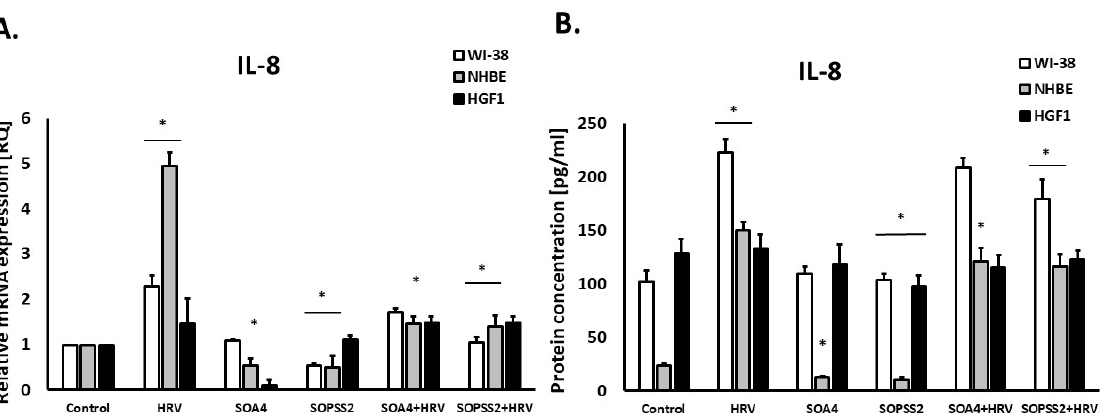
Figure 2. The effect of the extracts from transformed (SOA4) and transgenic (SOPSS2) Senna obtusifolia hairy roots and viral infection (HRV-16) on the expression of IL-8 on mRNA and protein levels in human lung fibroblasts, epithelial cells, and gingival fibroblasts. ( A ) presents mRNA expression of IL-8; ( B ) presents protein concentration in airway fibroblasts (WI-38), epithelial cells (NHBE) and gingival fibroblasts (HGF1).Data presented as mean ± SEM, * p < 0.05.